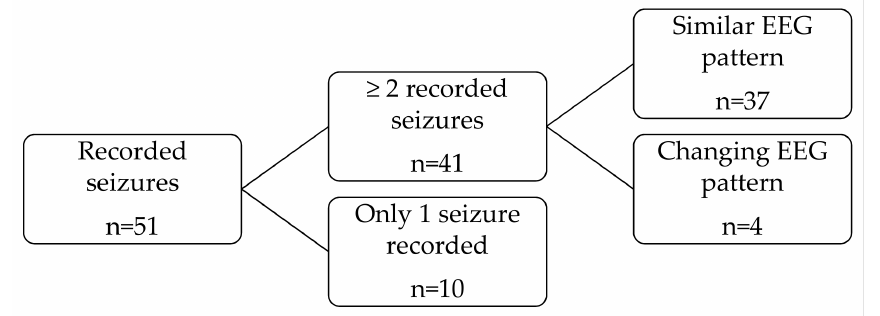
Figure 1. Variability of seizure